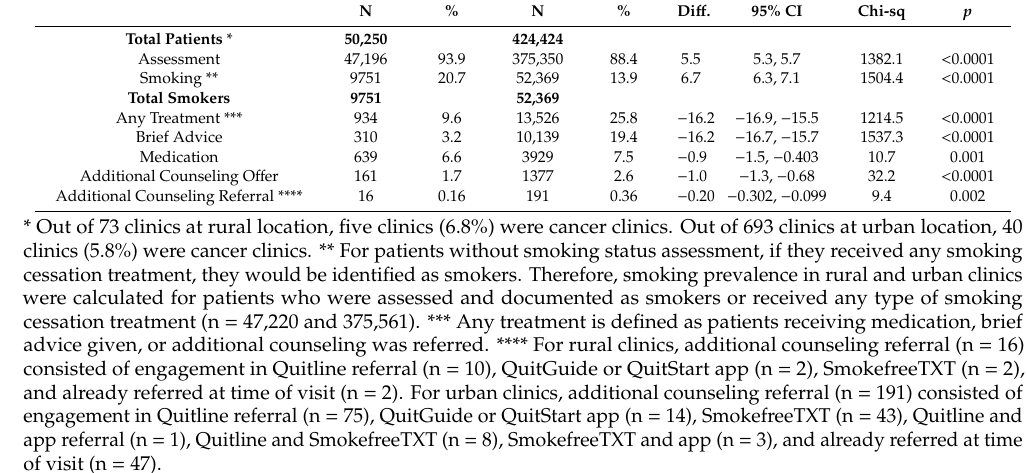
Table 3. Results of generalized estimating equations analyses predicting smoking prevalence and treatment engagement in urban and rural clinics adjusting for the clustering of patients within clinics. Outcome Predictor % Odds Ratio 95%CI Total Patients (N = 474,674) Assessment